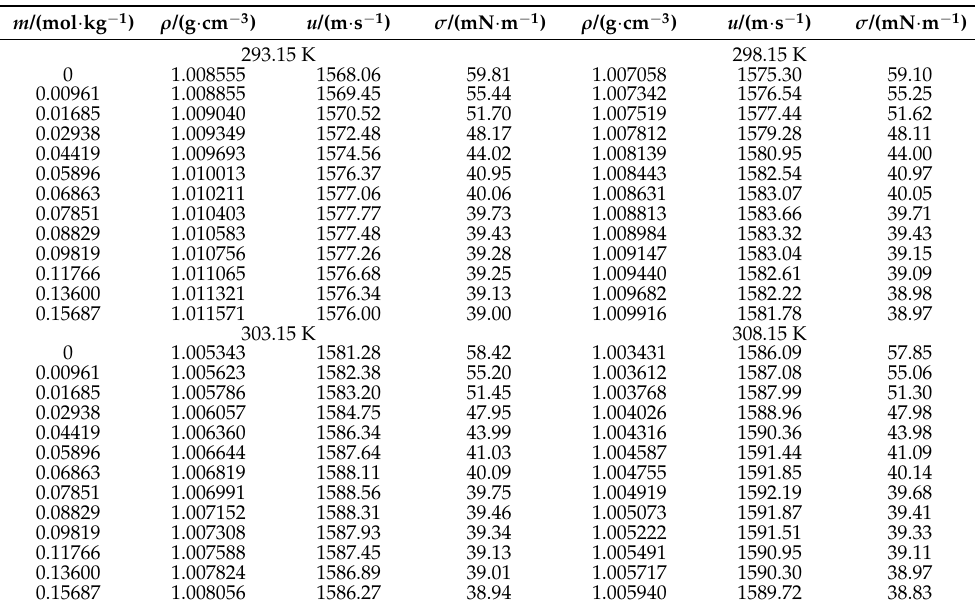
Table 3. Density, sound velocity, and surface tension for decyltrimethylammonium bromide (C 10 TAB) in aqueous solutions of 1,2-propanediol X OH = 0.03466 at temperatures between T = 293.15 K and 308.15 K at 75